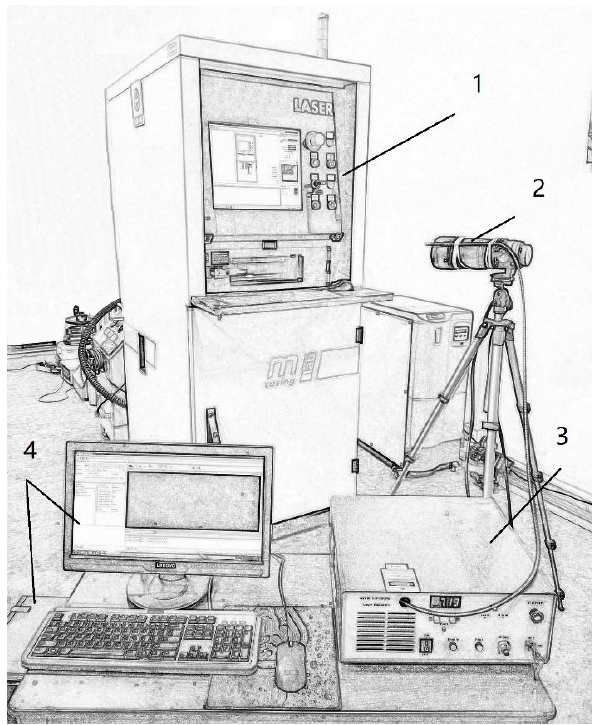
Figure 8. The method used to measure the dynamic molten pool. 1-Selective laser melting (SLM) machine; 2-camera; 3-laser generator; 4-computer.